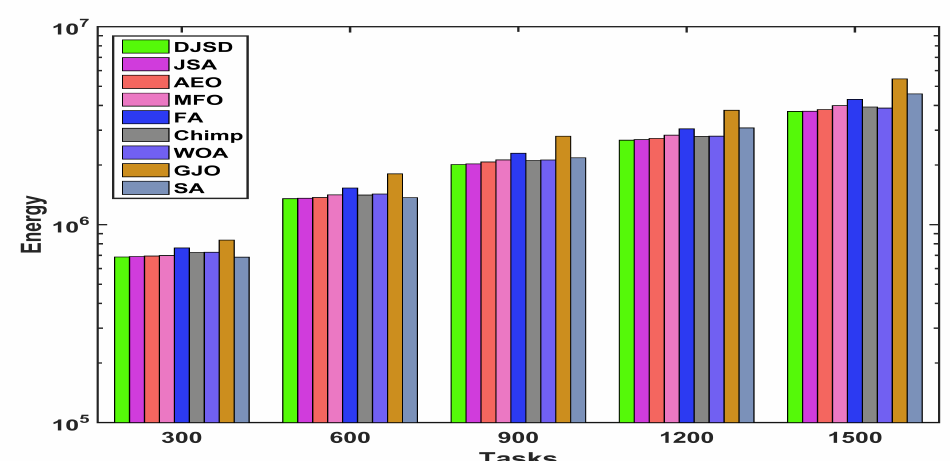
Figure 10. Total energy consumption for the synthetic workload.